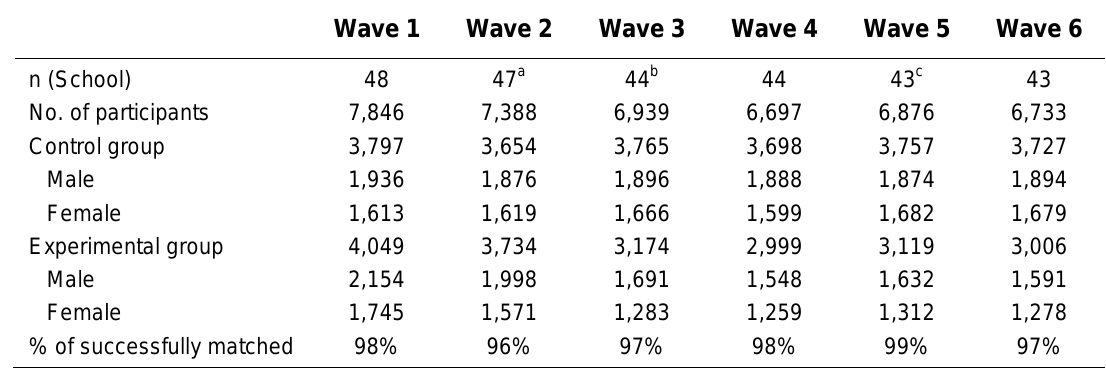
Number of Collected Questionnaires Across